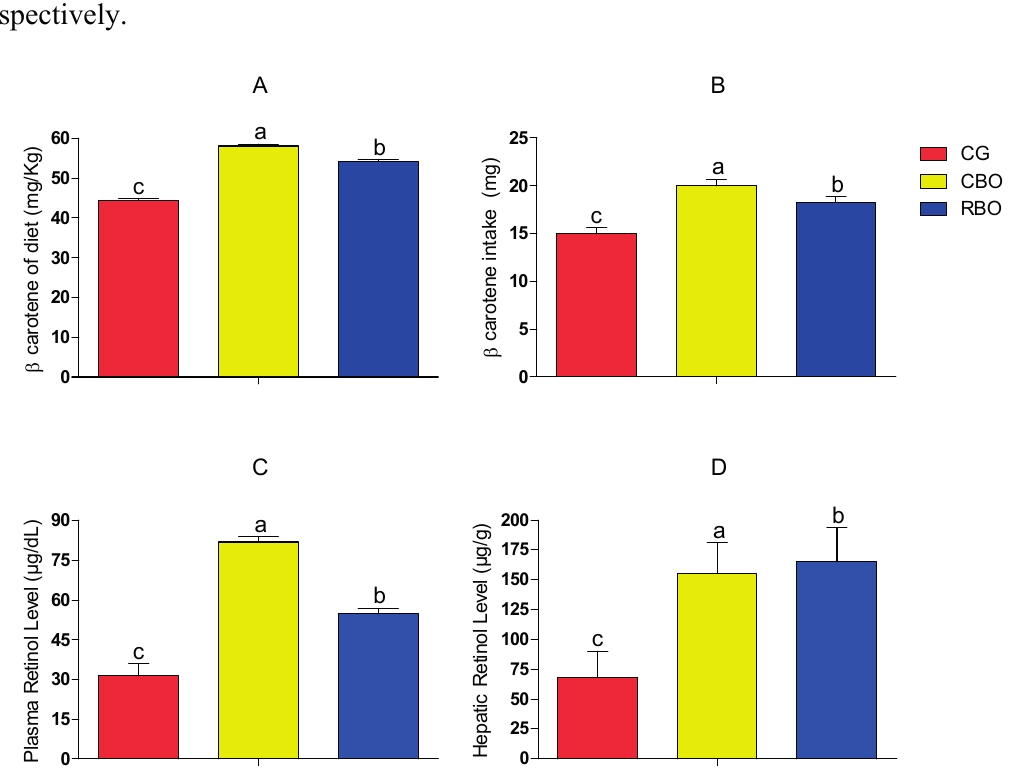
Figure 1. Content and intake of β -carotene of diet and serum and hepatic retinol of Wistar rats fed with diets added of soybean oil or refined or crude buriti oil. Panel A : β -carotene of diet; Panel B : β -carotene intake; Panel C : Plasma retinol level; Panel D : Hepatic retinol level. Means followed by different letters indicate significant difference with error probability p < 0.05, according to the Tukey test. Abbreviations: Groups: CG = control group with AIN-93G diet; CBO = experimental group with AIN-93G diet with crude buriti oil; RBO = Experimental group with AIN-93G diet with refined buriti